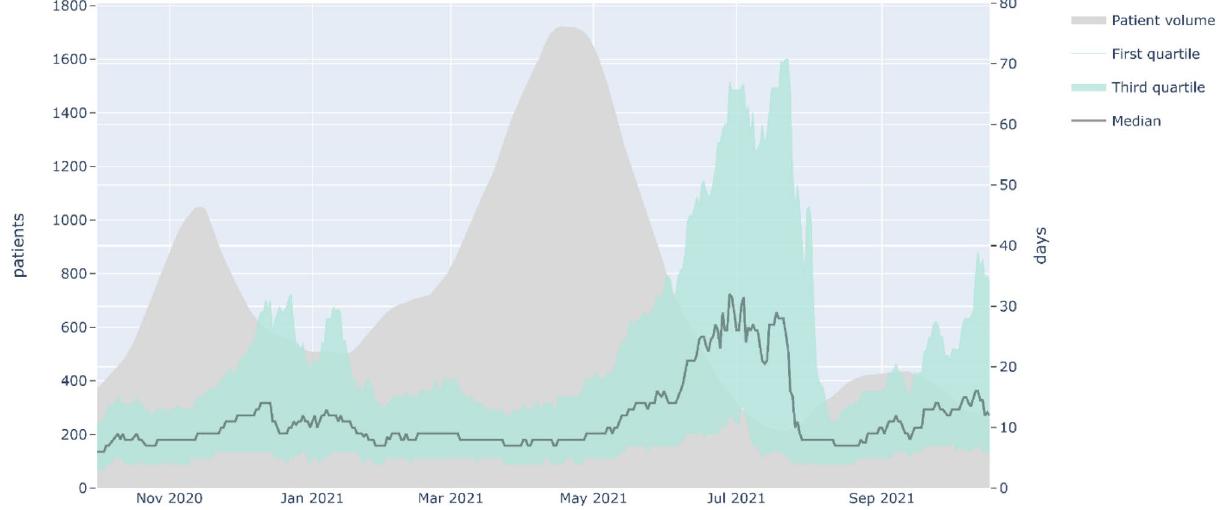
Figure 7. Evolution of the median length of stay in ICU during the 2nd and 3rd